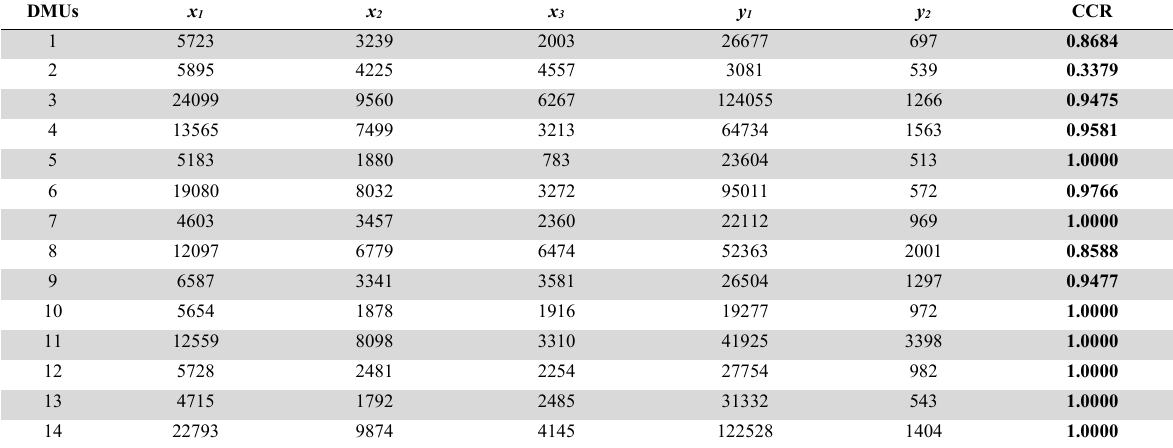
Data set of fourteen international passenger airlines